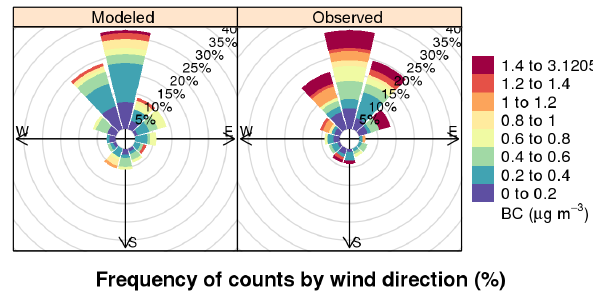
Figure 8. Pollution rose at Welgegund, comparison of WRF-Chem model results and station measurements. The plot shows the BC concentration modeled/measured for wind coming from the indi- cated directions and is created from the non-averaged data, e.g. 15- min values for the observations and 3-h values for the model